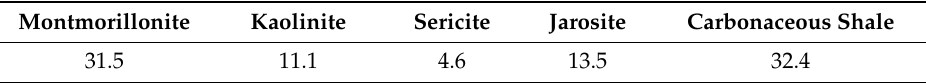
Table 1. The mineral composition of gangue (%).